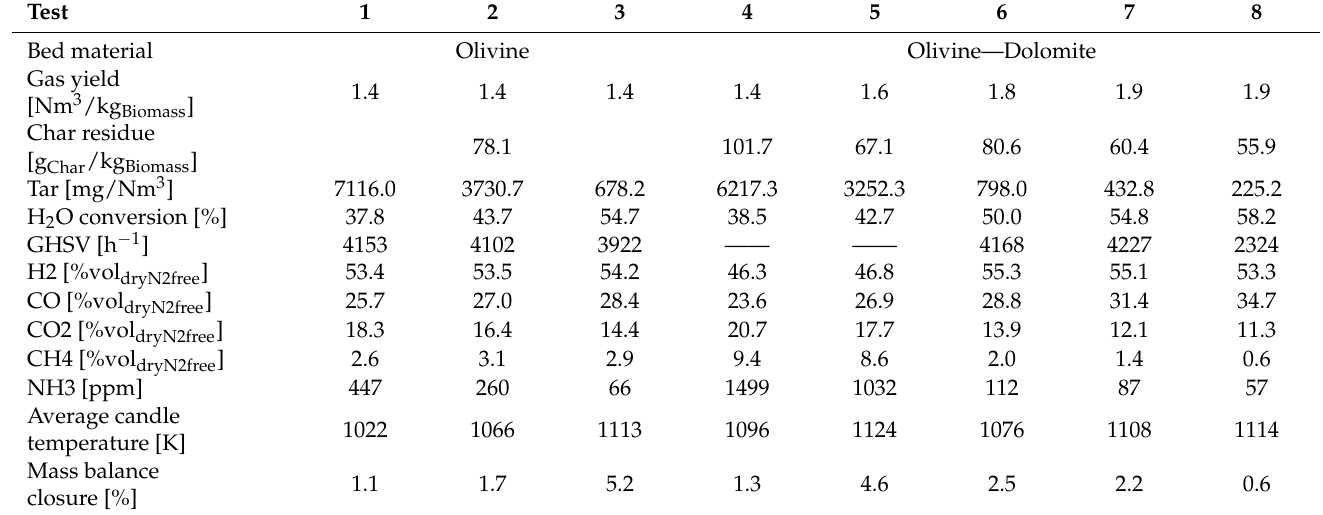
Table 4. Experimental results.